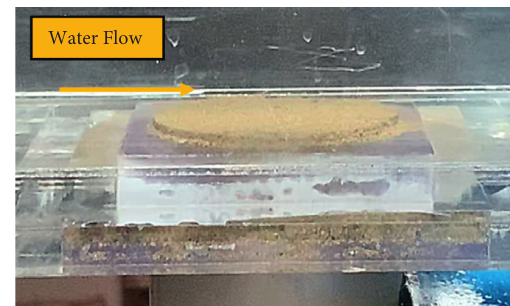
Figure 4: Schematic of sample pushing into a horizontal tube.